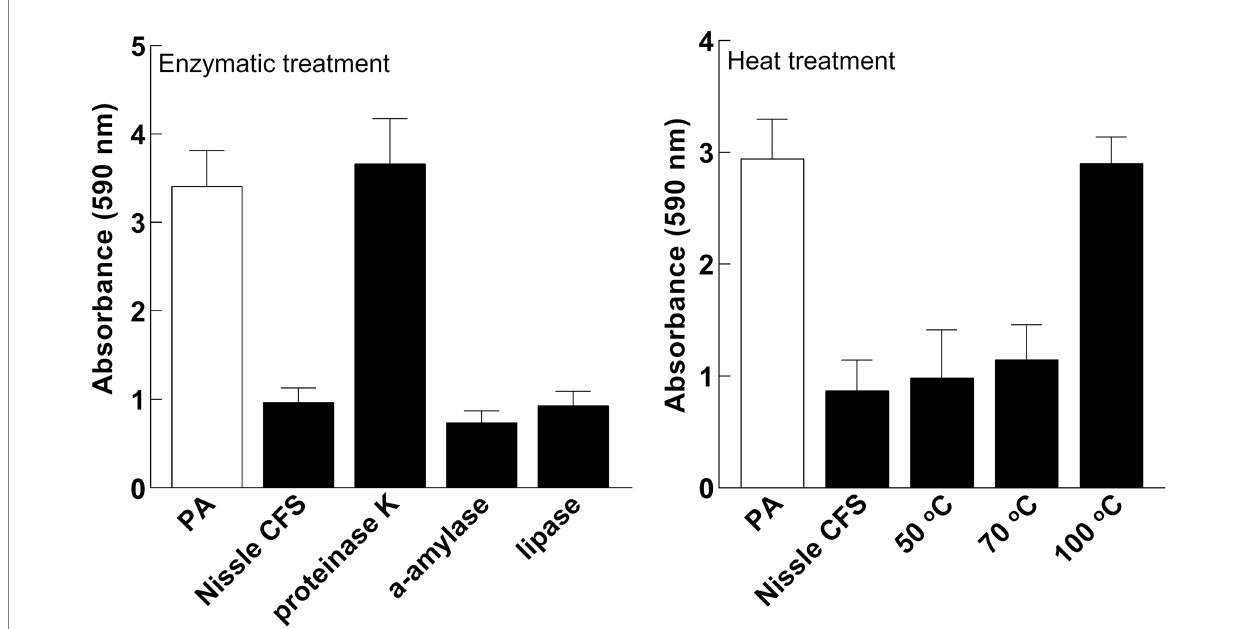
FIGURE 6 The active factor is proteinaceous and heat-labile. Effects of Nissle cell-free supernatants (CFS) on P. aeruginosa (PA) biofilm after enzymatic and heat treatment. Proteinase K eliminated the inhibitory effects. Lipase or α -amylase did not. The anti-biofilm activity was inhibited by heating to 100 ° C. Data are mean ± SEM, n =